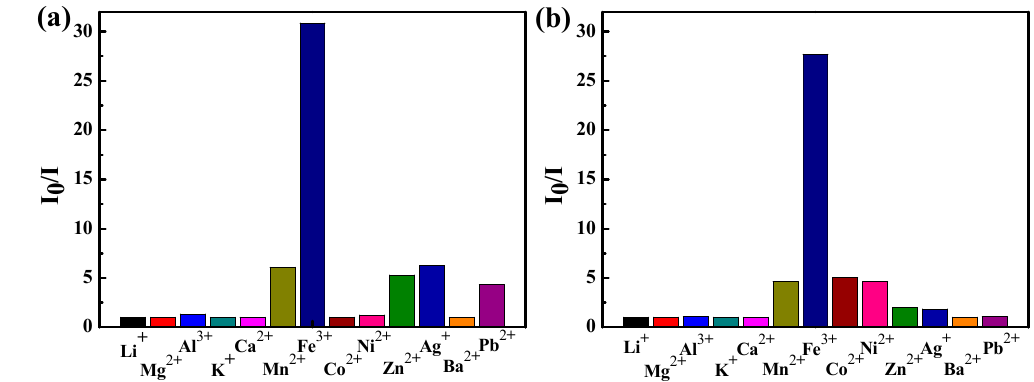
Figure 3. Photoluminescence response profiles for ( a ) PCaT and ( b ) PCT solutions by adding various cations in THF. Polymers 2017 , 9 , 427 10 of 16